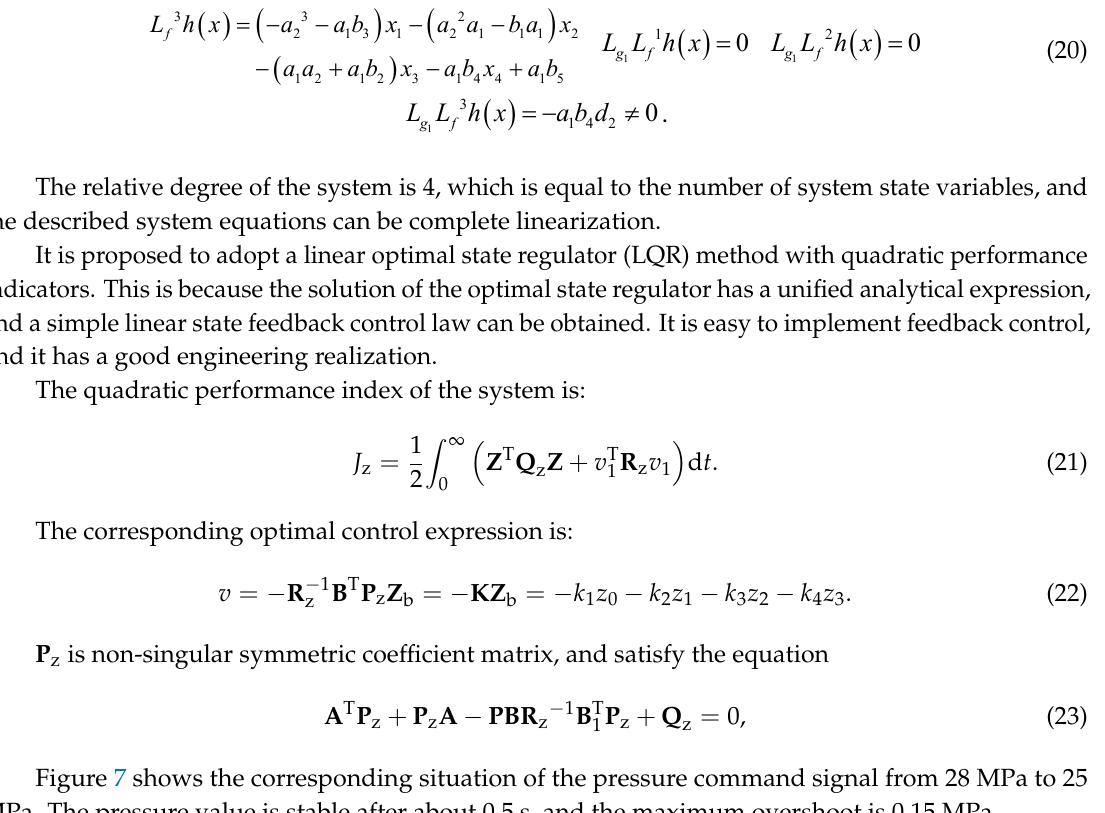
Figure 7. The delivery pressure of EHPAAPP with linear quadratic regulator (LQR) method in the case of input signal change from 28 MPa to 25